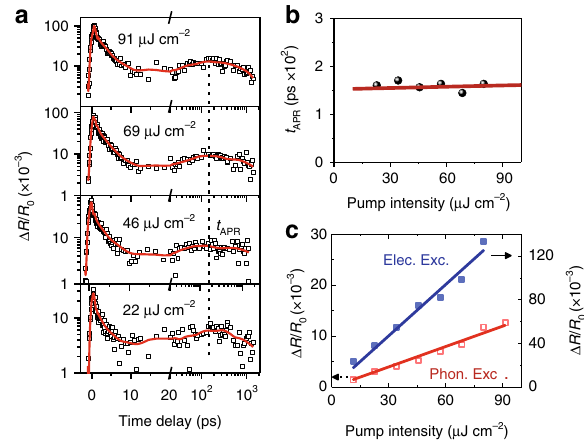
Fig. 4 Pump fl uence-dependent APR characteristics. a Differential re fl ectance kinetics at different pump fl uences. Dots are measurement results, and solid lines are smooth data for clari fi cation. b Extracted APR characteristic time as a function of pump fl uence. c Electronic (blue) and phononic (red) excitation intensities as a function of pump fl uence. In b , c , dots are measurement results, and solid lines are fi tting results from the APR